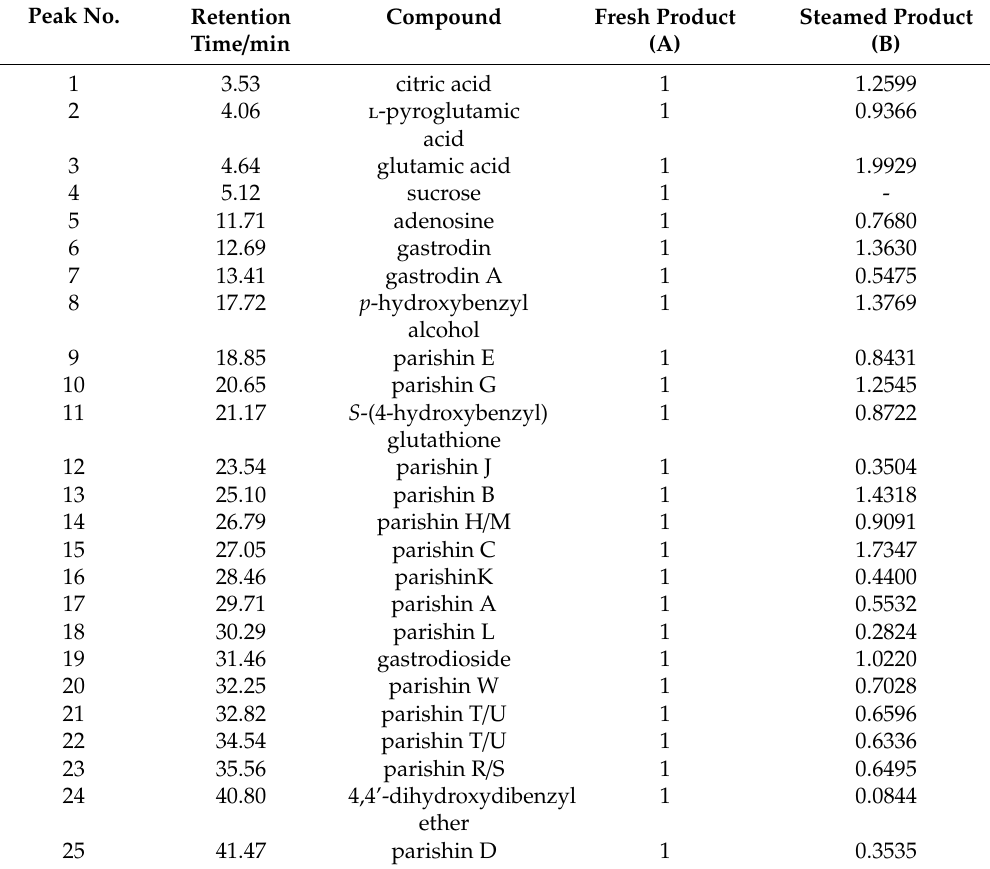
Table 2. The relative contents of 25 compounds in